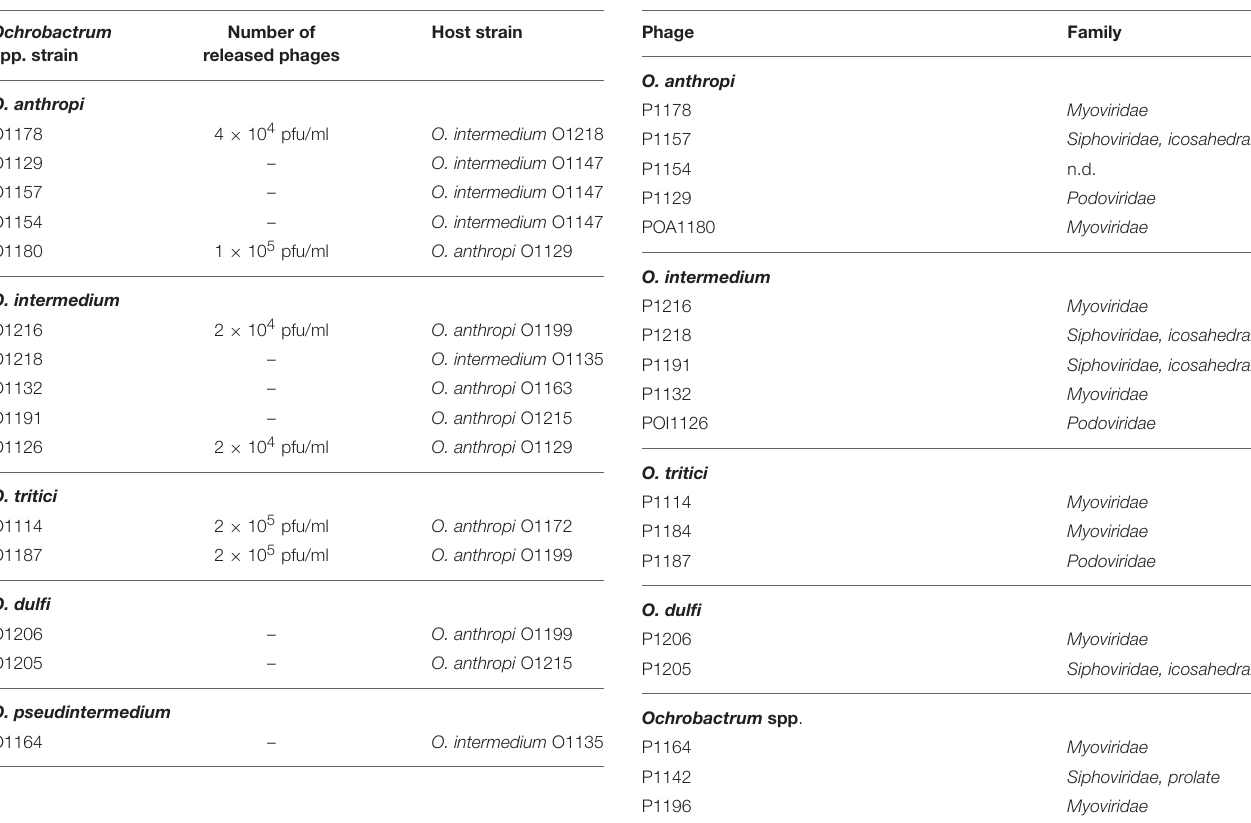
TABLE 4 | Morphology of Ochrobactrum spp. phages.